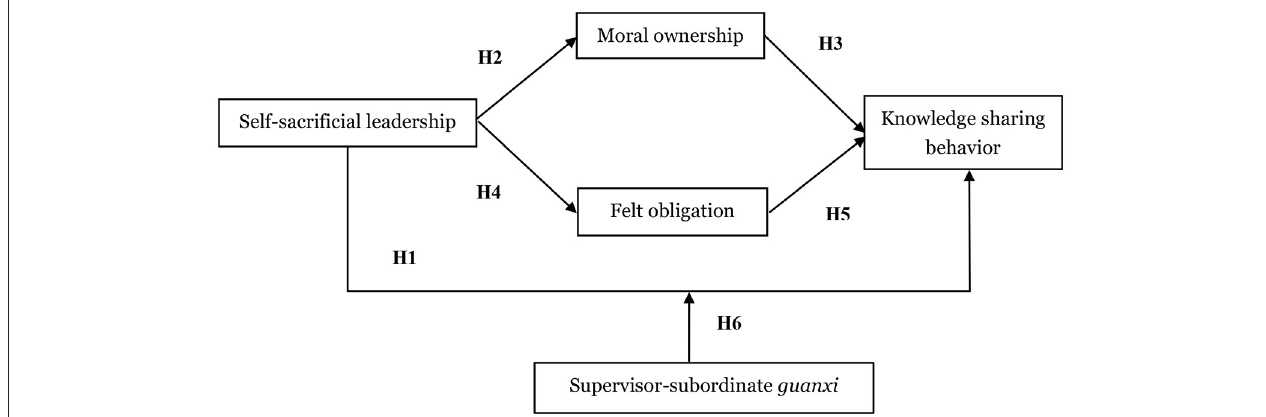
FIGURE 1 | Conceptual